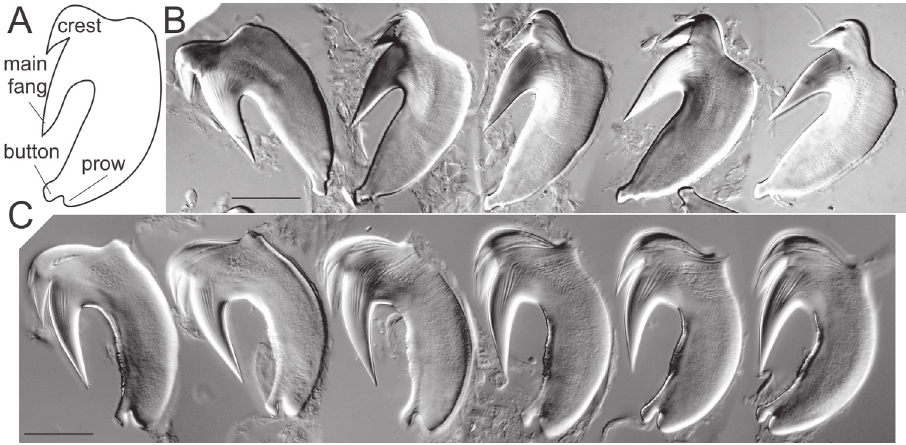
Figure 1. Uncinial parts and uncini of T. triserialis and T. setosus . A uncinial parts according to Nogueira et